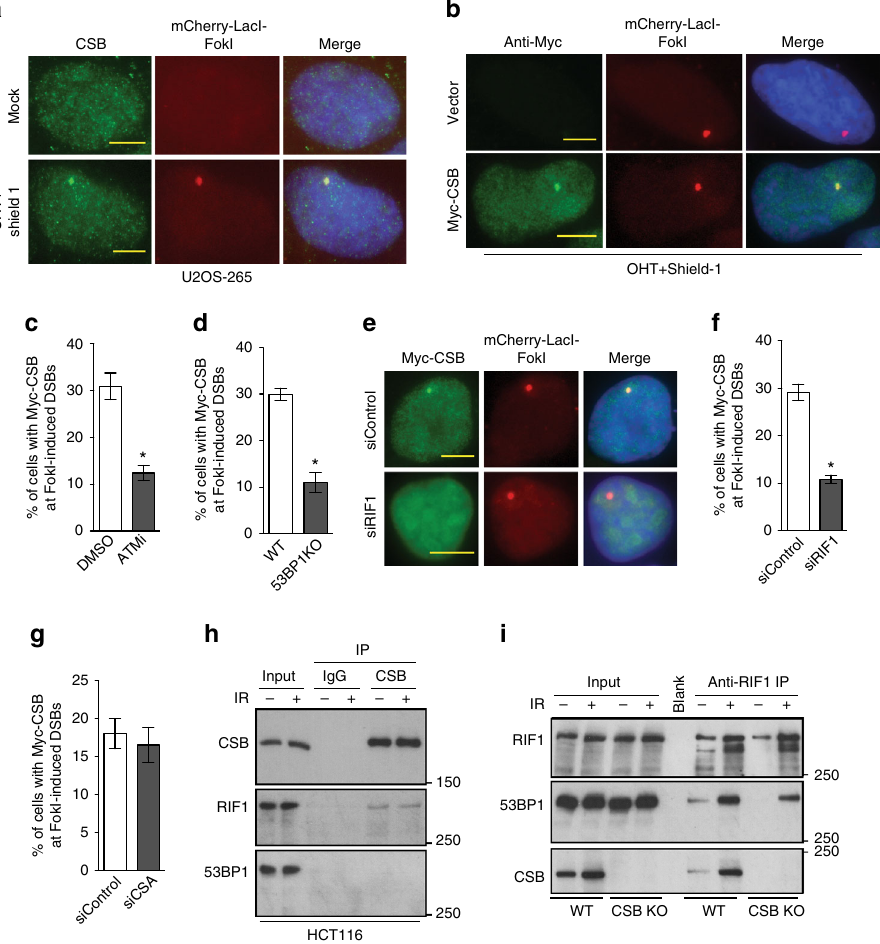
Fig. 1 CSB interacts with RIF1 and is recruited by RIF1 to FokI-induced DSBs. a Immuno fl uorescence of U2OS-265 cells with or without induction of FokI expression. Fixed cells were stained with anti-CSB antibody. Nuclei were stained with DAPI in blue in this and following fi gures. Scale bars, 5 μ m. b Immuno fl uorescence of U2OS-265 cells expressing Myc-tagged CSB with or without induction of FokI expression. Fixed cells were stained with anti-Myc antibody. Scale bars, 5 μ m. c Quanti fi cation of the percentage of U2OS-265 cells with Myc-CSB accumulated at FokI-induced DSBs. U2OS-265 cells were treated with DMSO or ATM inhibitor KU55933 for 1 h prior to induction of FokI expression. A total of 250 Myc-expressing cells were scored for each independent experiment in a blind manner. Standard deviations, referred to as SDs in this and the subsequent fi gures, from three independent experiments are indicated. * P < 0.05 (Student t test). d Quanti fi cation of the percentage of parental and 53BP1 KO U2OS-265 cells with Myc-CSB accumulated at FokI- induced DSBs. Scoring was done as described in 1c. SDs from three independent experiments are indicated. * P < 0.05 (Student t test). e Immuno fl uorescence with an anti-Myc antibody. 48 h prior to FokI induction, U2OS-265 cells were transfected with siRNA against scramble DNA (siControl) or RIF1 (siRIF1). Scale bars, 5 μ m. f Quanti fi cation of the percentage of siControl- and siRIF1-expressing U2OS-265 cells with Myc-CSB accumulated at FokI-induced DSBs. Scoring was done as described in 1c. SDs from three independent experiments are indicated. * P < 0.05 (Student t test). g Quanti fi cation of the percentage of siControl- and siCSA-expressing U2OS-265 cells with Myc-CSB accumulated at FokI-induced DSBs. Scoring was done as described in 1c. SDs from three independent experiments are indicated. h Coimmunoprecipitation with IgG and anti-CSB antibody in HCT116 cells treated with or without 20 Gy IR. Immunoblotting was performed with anti-CSB, anti-RIF1 and anti-53BP1 antibodies. Protein molecular weight markers in kDa are indicated in this and the subsequent fi gures. i Coimmunoprecipitation with anti-RIF1 antibody in parental (WT) and CSB knockout (KO) HCT116 cells treated with or without 20 Gy IR. Immunoblotting was performed with anti-RIF1, anti-53BP1 and anti-CSB